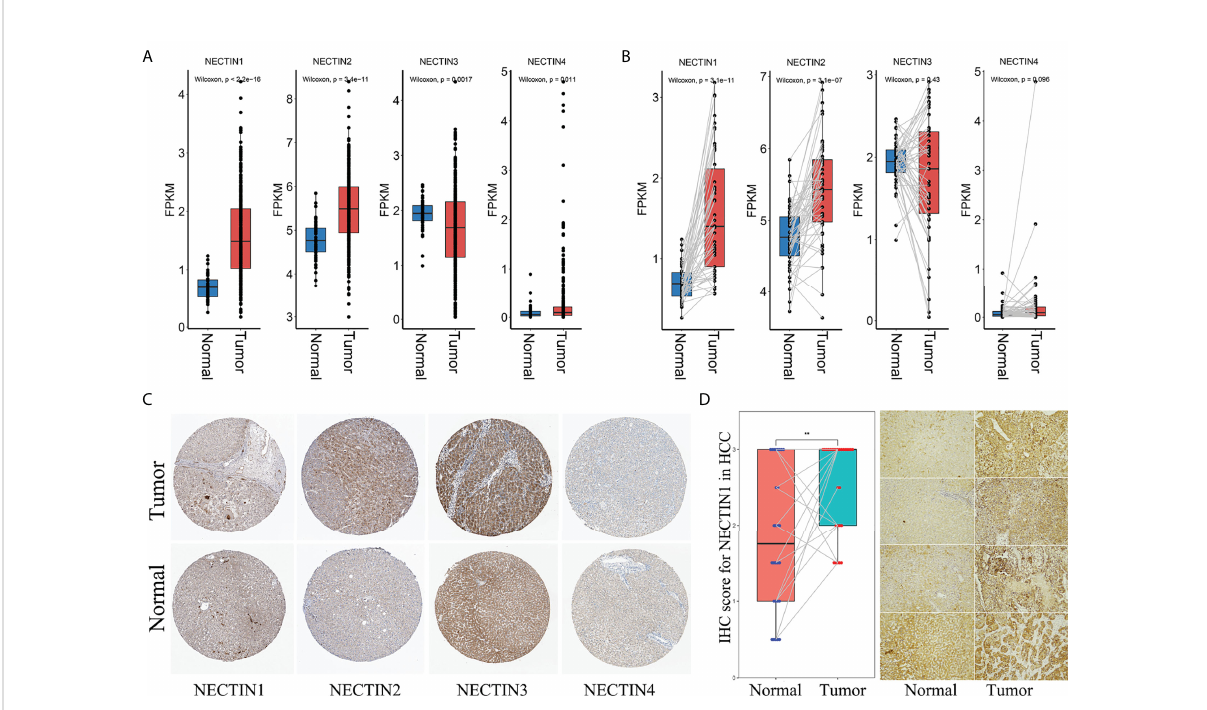
FIGURE 1 Different expressions of nectin-1, nectin-2, nectin-3, and nectin-4 genes and proteins in HCC tissue. (A) Differential expression of nectin-1, nectin-2, nectin-3, and nectin-4 genes in TCGA-LIHC patients. (B) Differential expression of nectin-1, nectin-2, nectin-3, and nectin-4 genes in